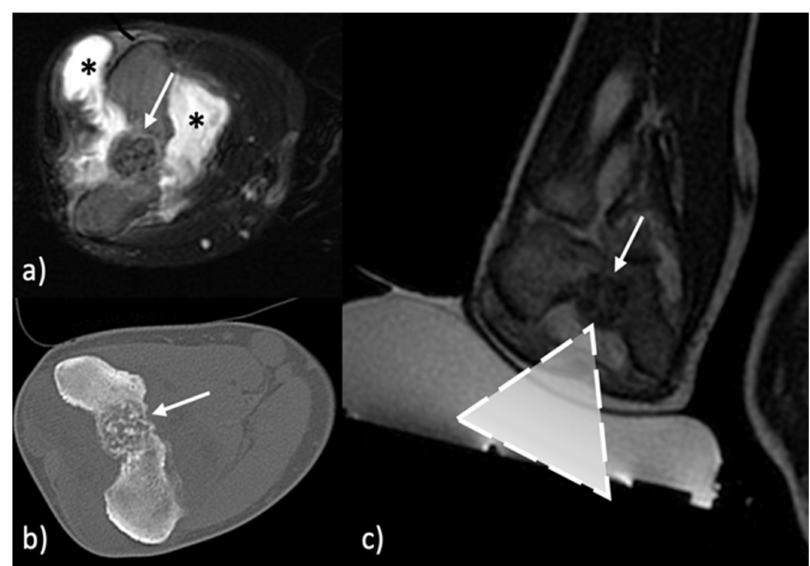
Figure 2. Intra-articular osteoblastoma of the elbow ( a ) Pretreatment T2-weighted fast spin-echo MR with fat-saturation shows the lesion (arrow), bone edema and the reactive intra-articular fluid (asterisk). ( b ) Pretreatment CT shows the nidus (arrow) of the osteoblastoma. ( c ) MR image during treatment with the US transducer in contact with the skin (dashed triangle represents the US beam focused on the target indicated by the